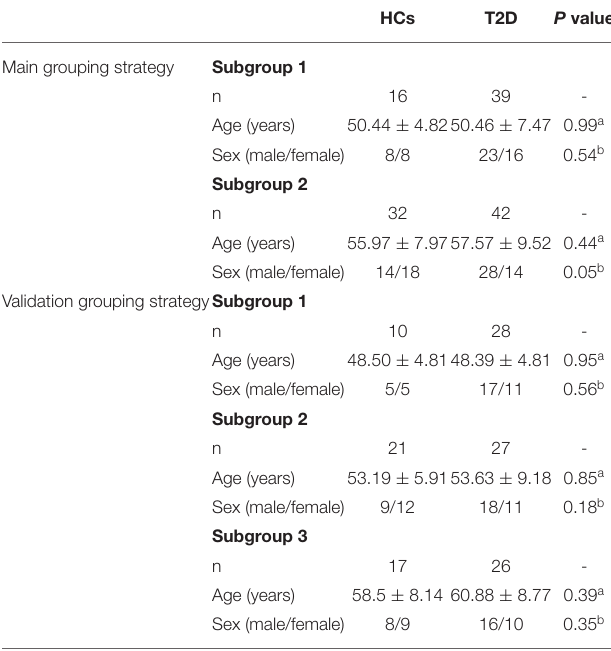
TABLE 2 | Demographic and clinical variables in